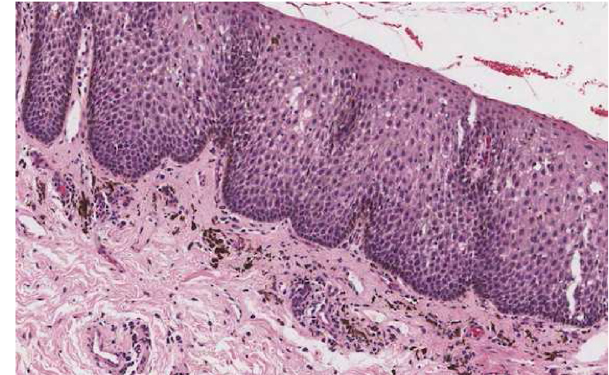
Figure 2. Microphotograph of the stained biopsy tissue. Microphotograph of hematoxylin and eosins stained tissue shows the parakeratinized, hyperplastic, stratified squamous epithelium with acanthosis, and long rete ridges. Many benign dendritic melanocytes with dendritic processes can be seen distributed in the epithelium, as well as melanin deposits in the lamina propria.